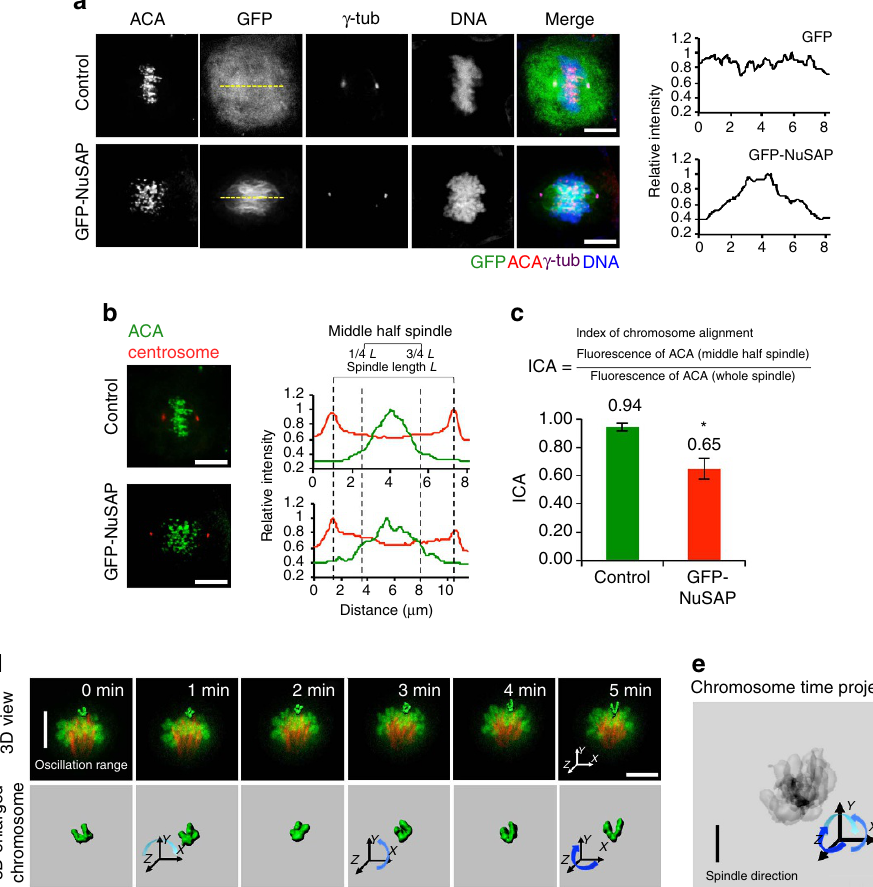
Figure 1 | NuSAP regulates chromosome alignment and orientation during metaphase. ( a ) Fluorescent images of synchronized metaphase HeLa cells expressing GFP-NuSAP and GFP-vector (control). The line profiles of the GFP channel are presented in the graph on the right. Mitotic spindles were labelled with anti- g -tubulin and anti-CREST, and DNA with Hoechst 333342. Scale bar, 5 m m. ( b ) Representative images using the ICA method to analyse centromere alignment in HeLa cells expressing GFP-NuSAP and GFP-vector only (control), with data represented as a line graph on the right. The distribution of ACA fluorescence within the spindle region was measured along the spindle axis following staining with anti- g -tubulin and anti-Crest. ( c ) ICAs in HeLa cells expressing GFP-NuSAP and GFP-vector only (control) were analysed as in b . Data were collected from three independent experiments and error bars represent ± s.d. * P o 0.001, by t -test. ( d ) 3D time-lapse imaging and 3D single chromosome surface of chromosome oscillation in synchronized metaphase mCherry-H2B HeLa cells stably expressing GFP-NuSAP. Changes in the chromosome orientation are indicated by arrows. Scale bar, 5 m m. ( e ) Time project image representing the single chromosome